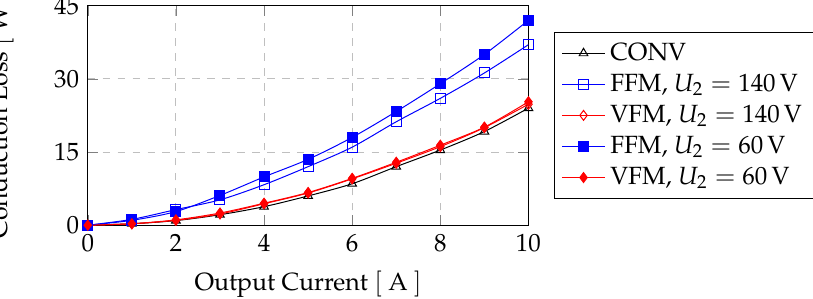
Figure 8. Conduction loss of three converters ( U 1 = 80 V, r ON = 40 m Ω ). The input and output voltages can influence the RMS current by deciding t 1 and t 2 . The